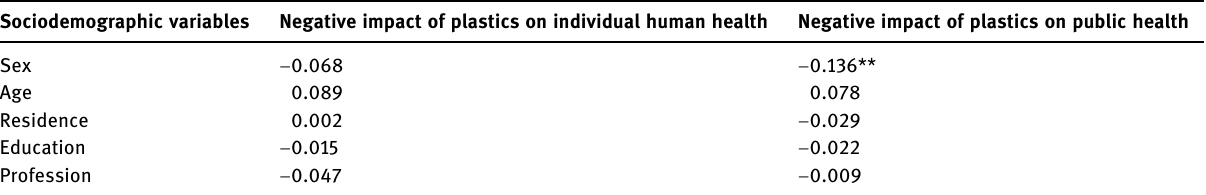
Table 4: Spearman correlations between the sociodemographic variables and the perceived negative impact of plastics on health Sociodemographic